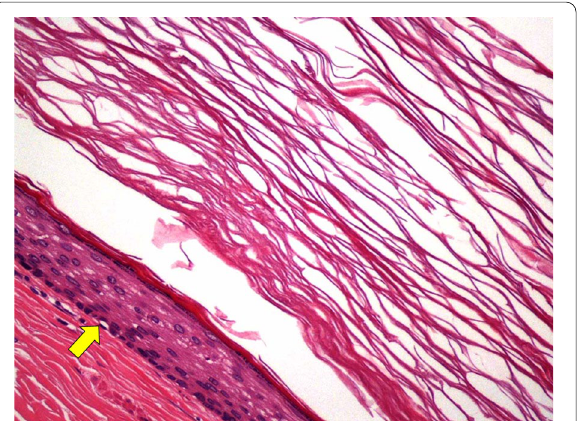
Fig. 5 Histological examination (hematoxylin and eosin stain, The cyst wall of the tumor is lined by keratinized stratified squamous epithelium (arrow). No malignant findings are